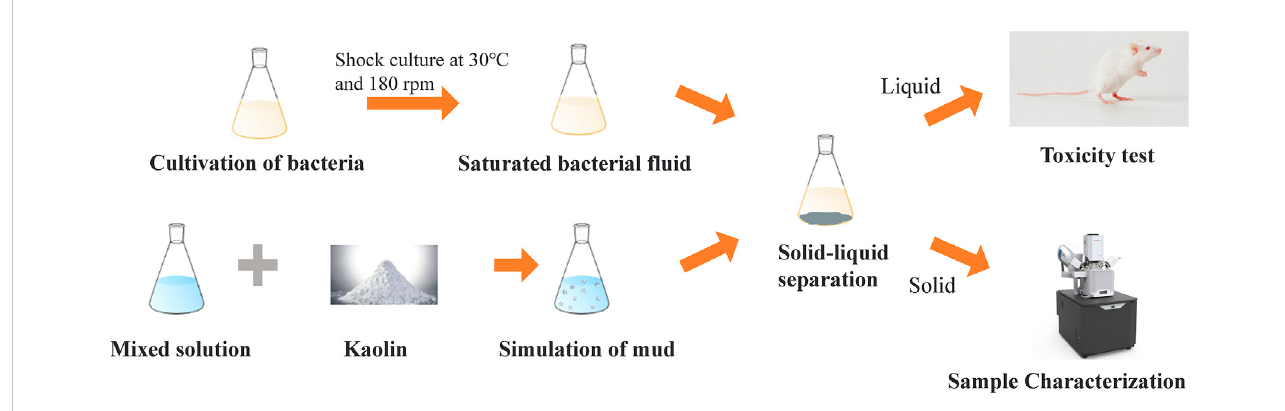
The process of waste mud disposal by